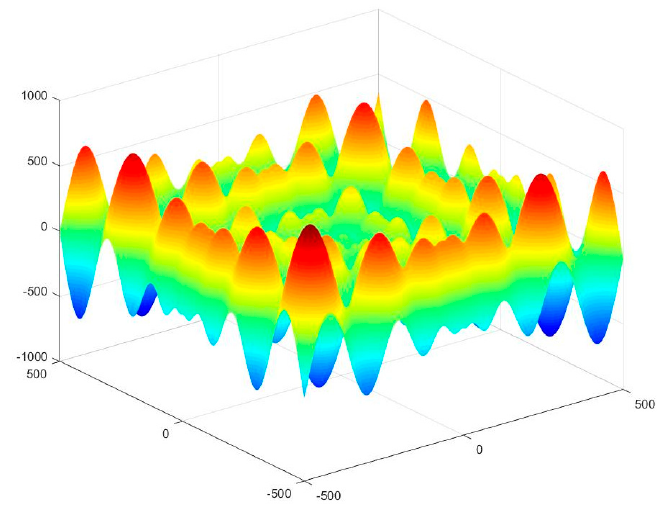
Figure 6. Three-dimensional image of Schwefel function ( f 4 ).